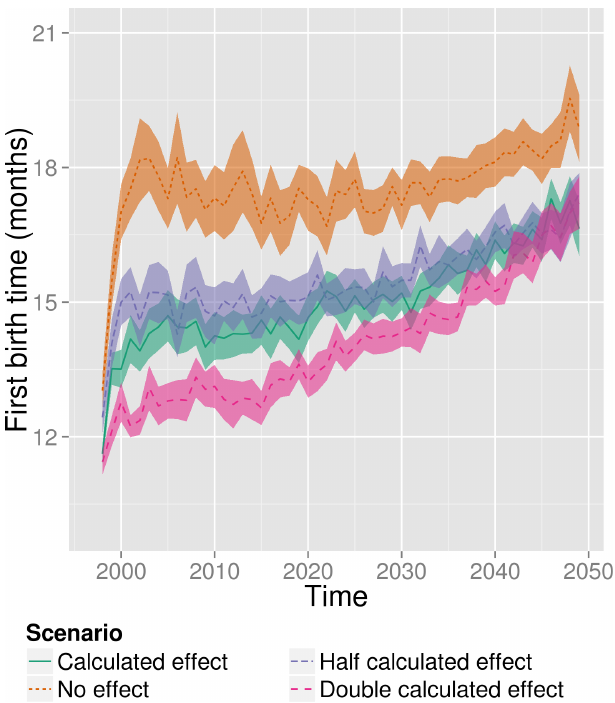
Fig. 4 . First birth timing for women in agricultural neighborhoods, plotted for the four scenarios in scenario set ‘A.